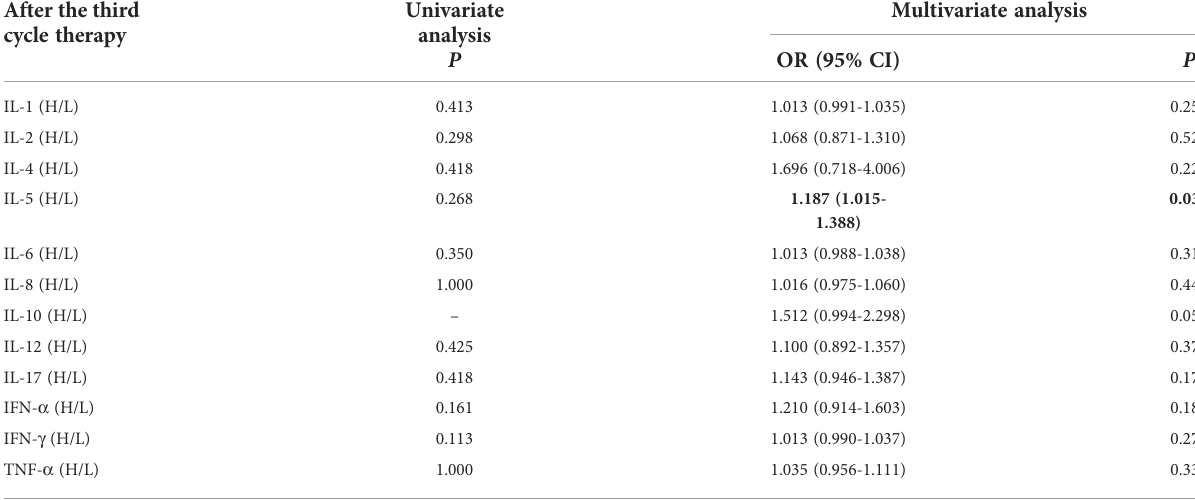
TABLE 5 Univariate and multivariate analysis results of cytokine levels after the third cycle therapy between AE and NAE. After the third cycle